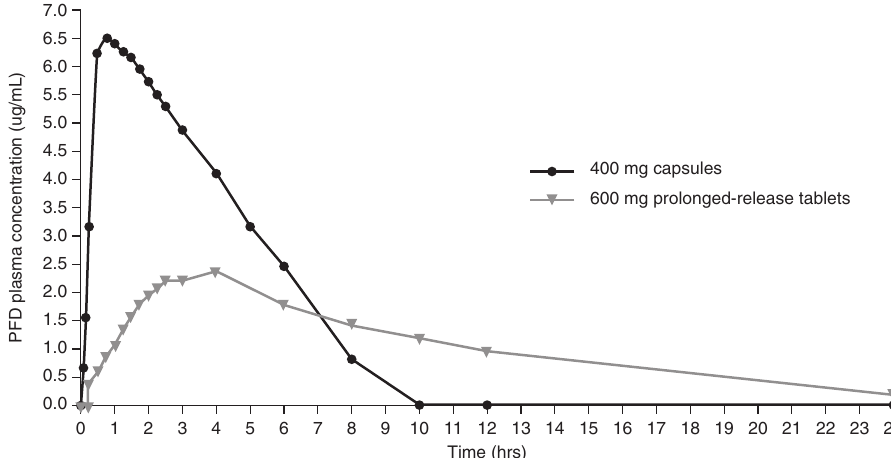
Figure 3 . Mean plasma concentration-time profile of PFD 400 mg capsules versus 600 mg prolonged-release tablets. PFD,